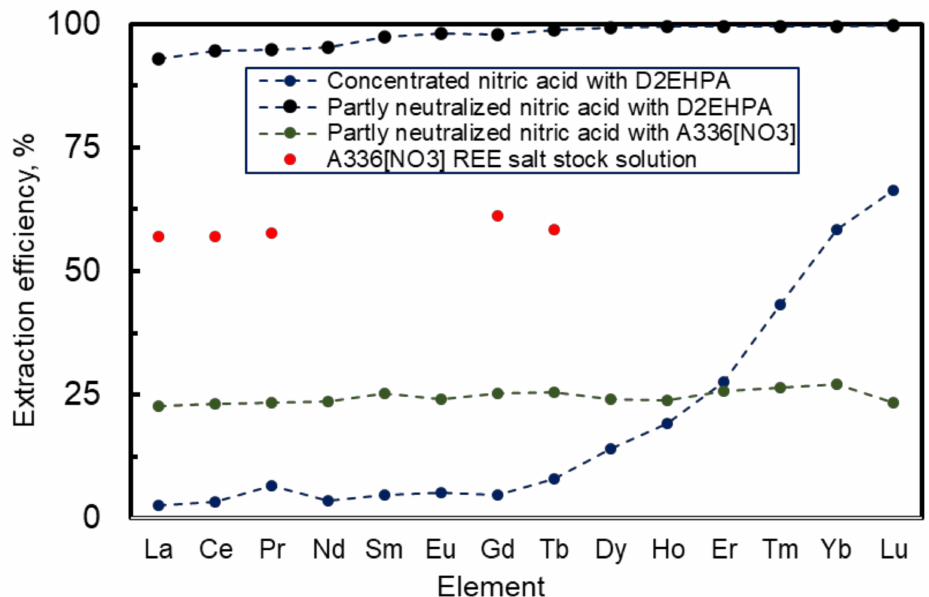
Figure 3. Extraction efficiencies of REE using D2EHPA and A336[NO 3 ] as the extractants from phosphorite ore nitric acid solution and extraction efficiency of A336[NO 3 ] from a stock solution of selected REE nitrates (content described in Table 1. 7.5M nitric acid designates the concentrated acid and raffinate at pH 1.5 value designates diluted nitric acid media. The time of extraction was 1 h all time. Extraction was performed at room temperature. Undiluted D2EHPA and A336[NO 3 ] were used as extractants.